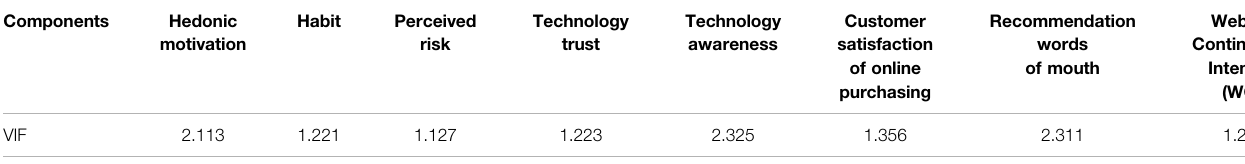
TABLE 1 | Common method variance assessment via full collinearity estimate criteria. Components